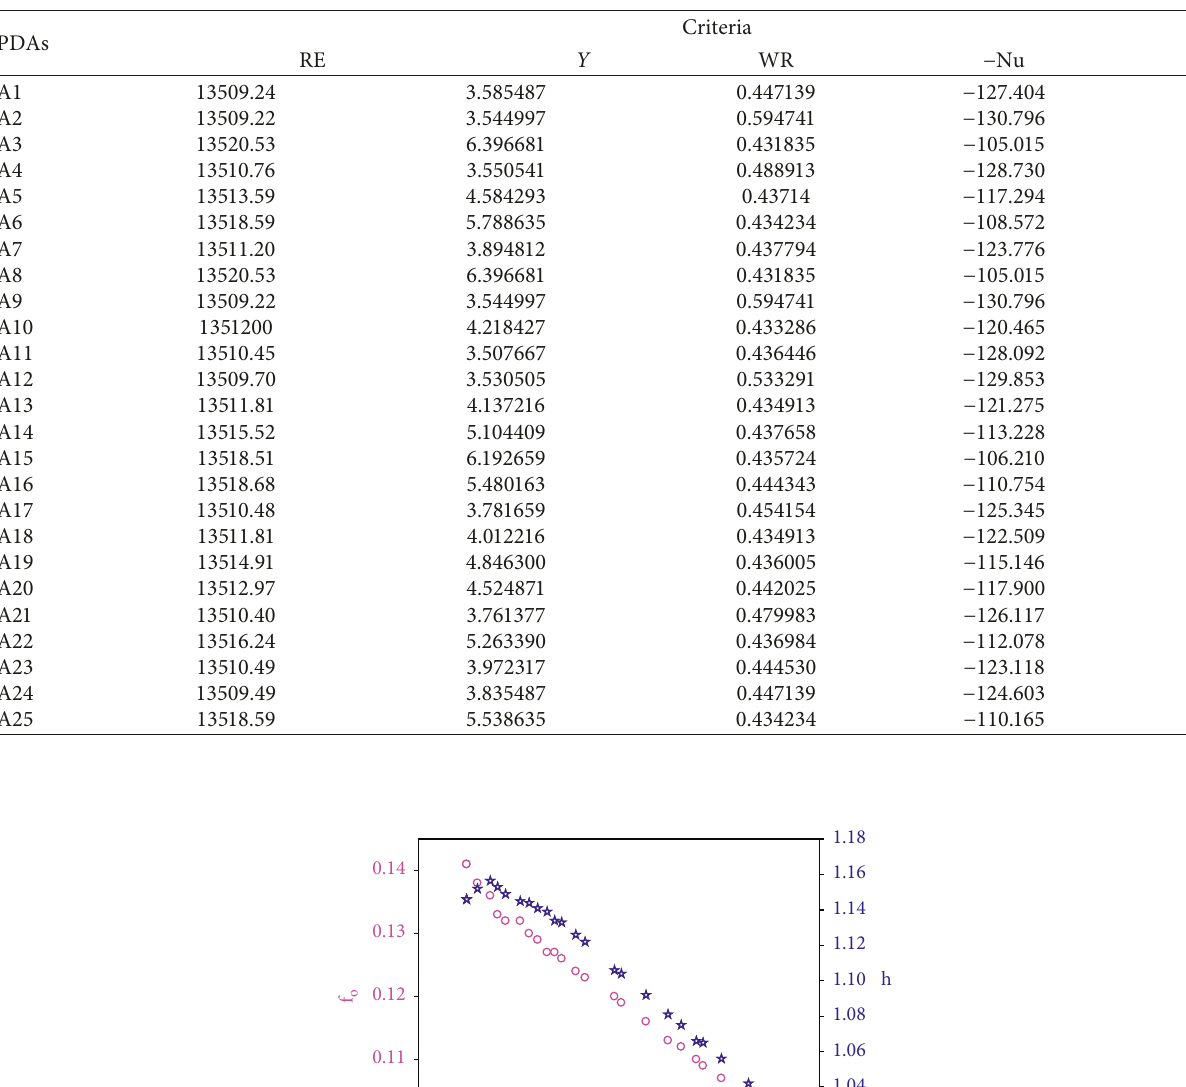
Table 7: Optimal configurations of W-cut twisted tapes (Pareto front solutions from GA).